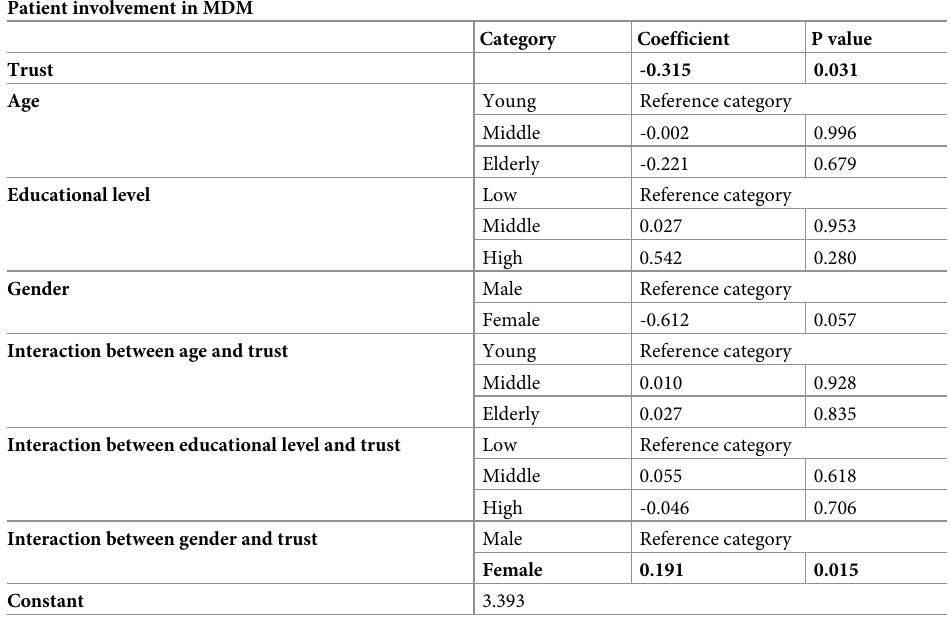
Table 5. Relationship between patient involvement in MDM and trust, including interactions with sociodemo- graphic characteristics, results from regression